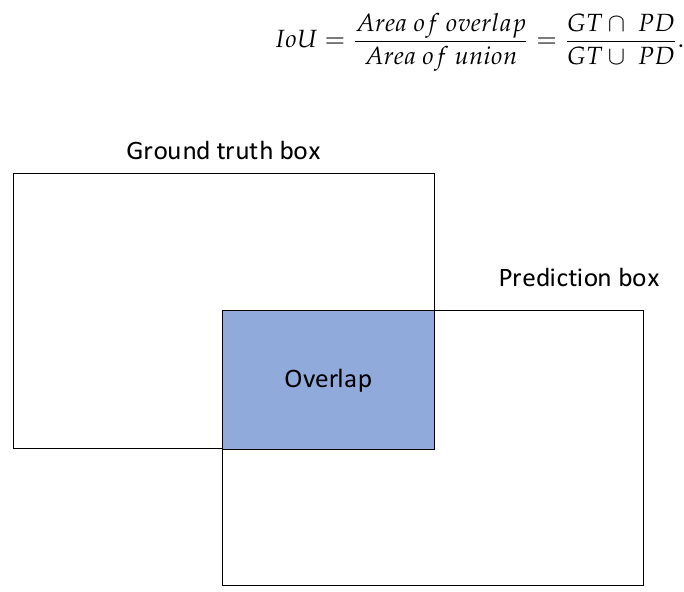
Figure 10. The overlap between the predicted ground truth and a detected object.